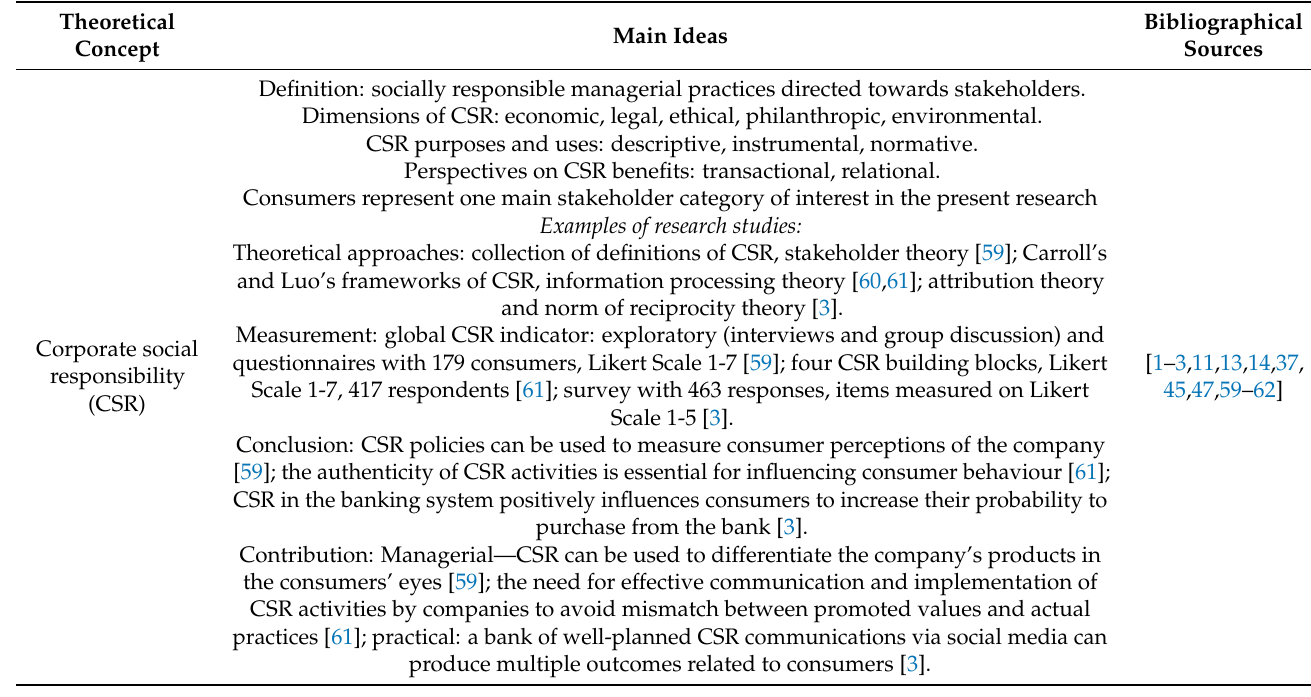
Table 1. Summary of the main literature.